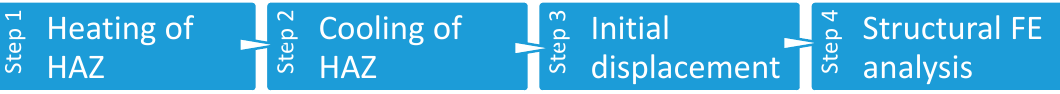
Figure 2. FE loading procedure and steps.